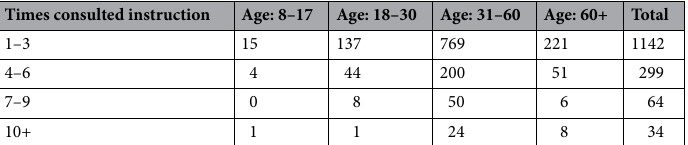
Times consulted